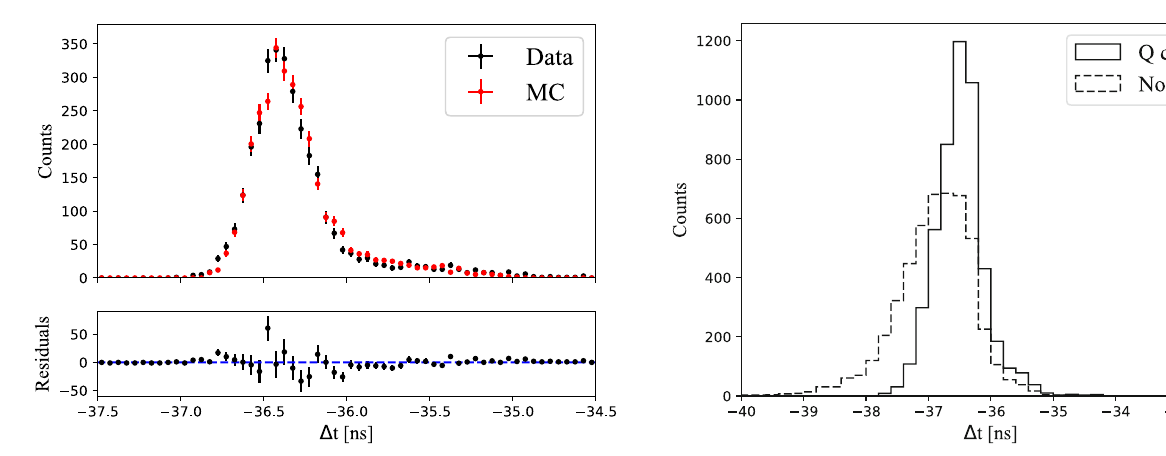
Fig. 7 TTS-calibrated timing distributions, in both data and MC, for a water target. The χ 2 /ndf comparing the data and MC is 41.9/40